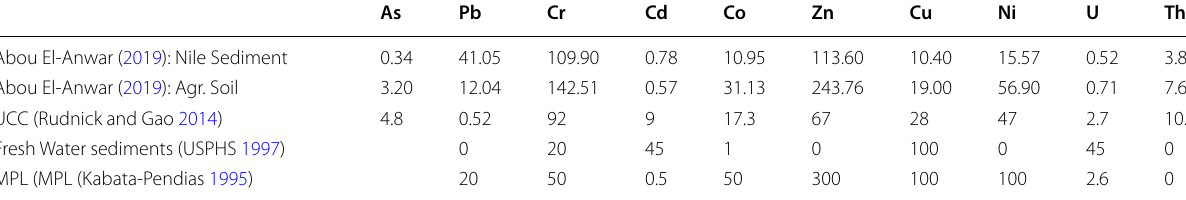
Table 2 The concentration of the elements in studied samples (ppm) compared with others As